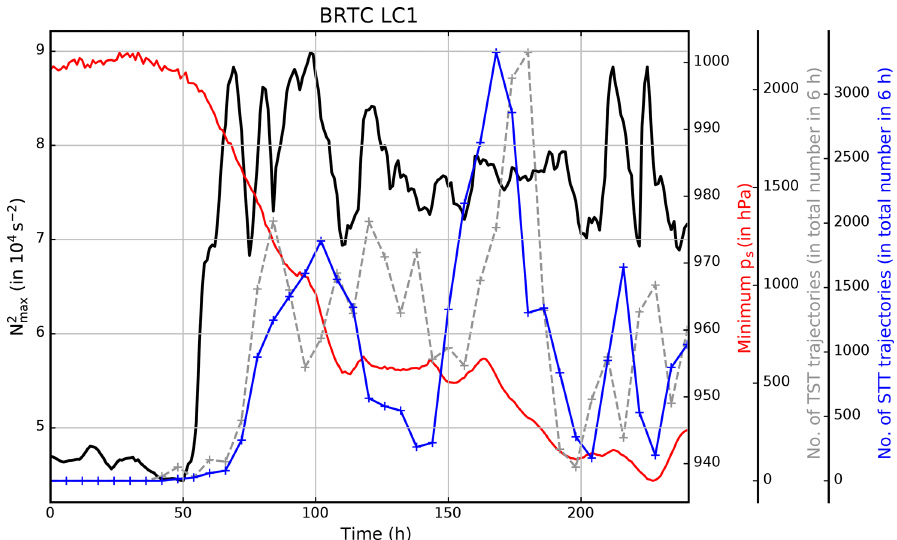
Figure 9. Temporal evolution of maximum static stability (black, in 10 − 4 s − 2 ), minimum surface pressure (red, in hPa) as well as the number of TST and STT trajectories per 6h interval over the course of the idealized baroclinic life cycle experiment BRTC LC1. The maximum static stability N 2 max is derived by first averaging the static stability in the vertical between the altitudes of the local lapse rate tropopause and 1km above. The maximum value is then determined from the resulting two-dimensional field over the horizontal model domain.